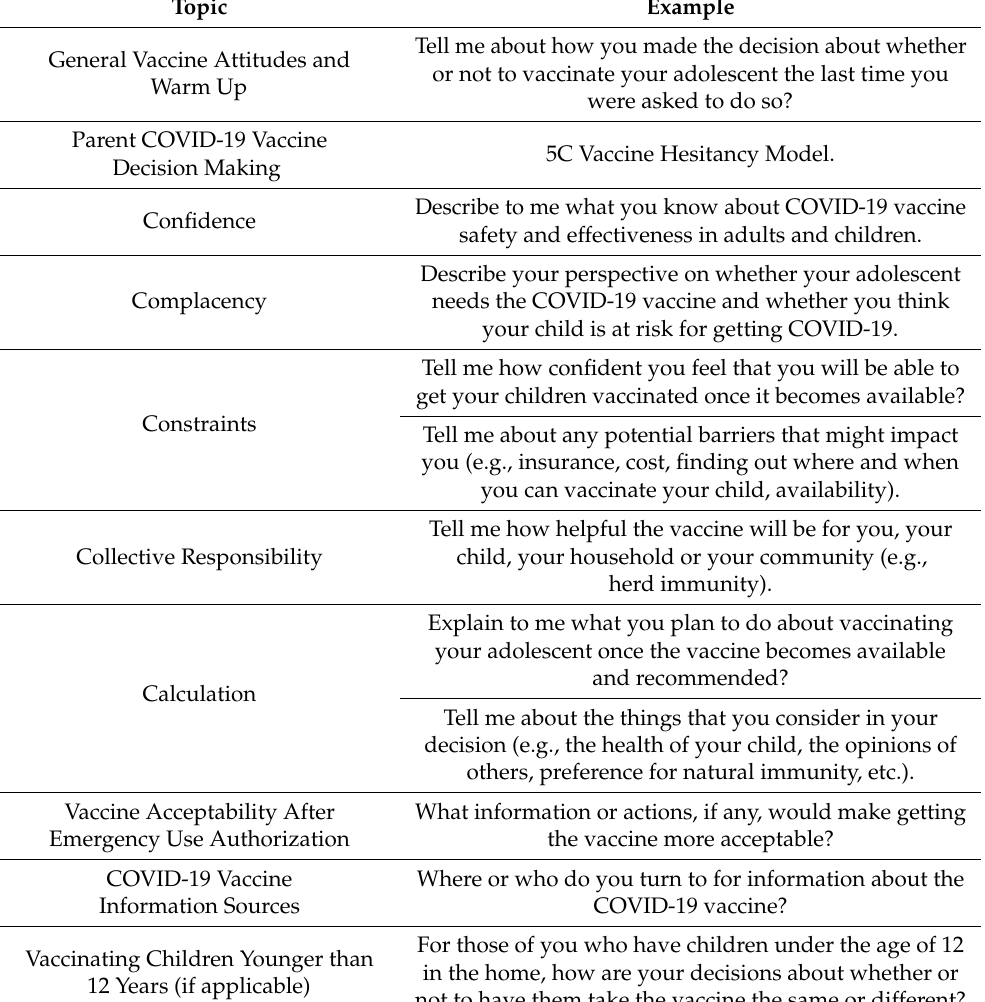
Table 2. Focus Group Discussion